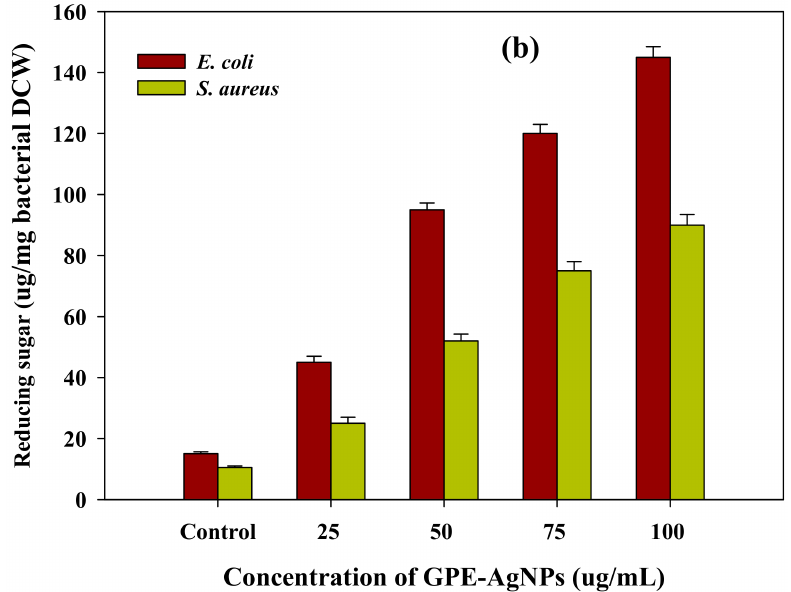
Figure7. Cellularleakageanalysisof( a )proteincontentand( b )reducingsugarfromthecellsuspensions of E. coli and S. aureus bacteria treated with di ff erent concentration of GPE-AgNPs after 6 h of